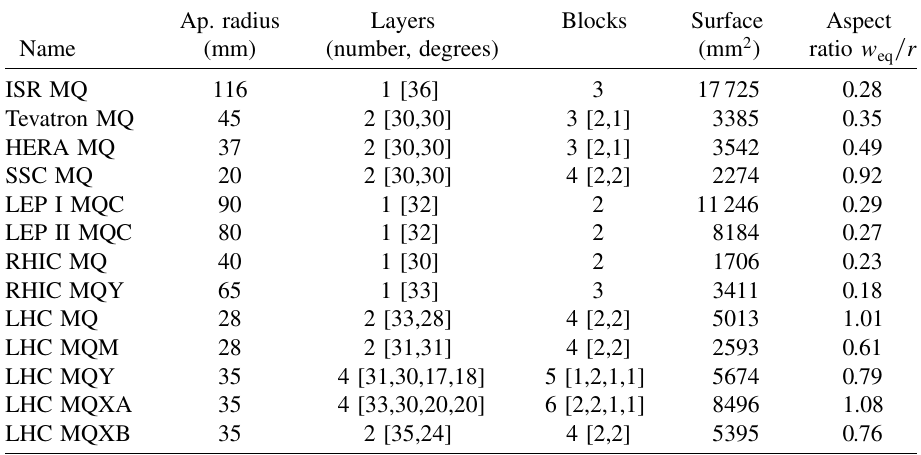
TABLE IV. Parameters of coil layouts of 13 superconducting quadrupoles. Ap. radius Layers Blocks Surface